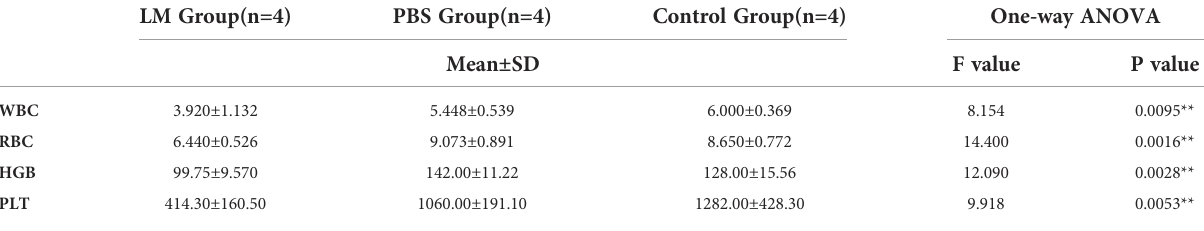
TABLE 5 The statistical results of haematology tests among three groups.